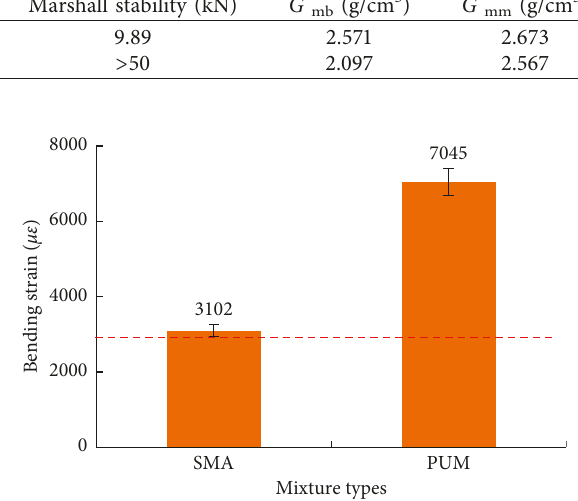
Figure 13: Results of the low-temperature bending